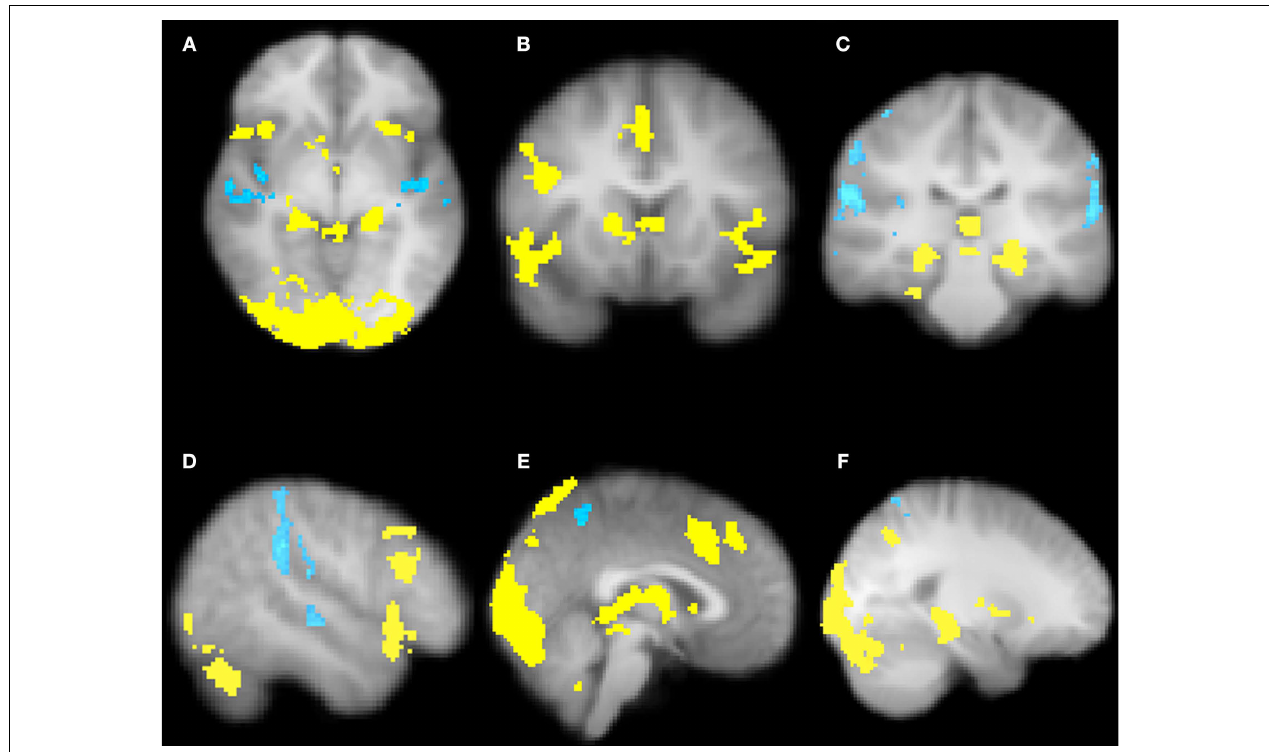
are associated with negative SEE. (B) Coronal section shows bilateral anterior insula, ventral striatum, right dorsolateral prefrontal cortex, and pre- supplementary motor area/dorsal anterior cingulate. (C) Coronal section shows bilateral posterior hippocampus. (D) Right lateral section shows DLPFC, VLPFC, and TPJ and STS. (E) Sagittal section shows preSMA/DACC. (F) Sagittal section shows posterior hippocampus/parahippocampus. All clusters survive whole brain correction using cluster correction, Z > 2.3, p < 0.05 and are displayed on the group average T1 image using the radiological convention (left =